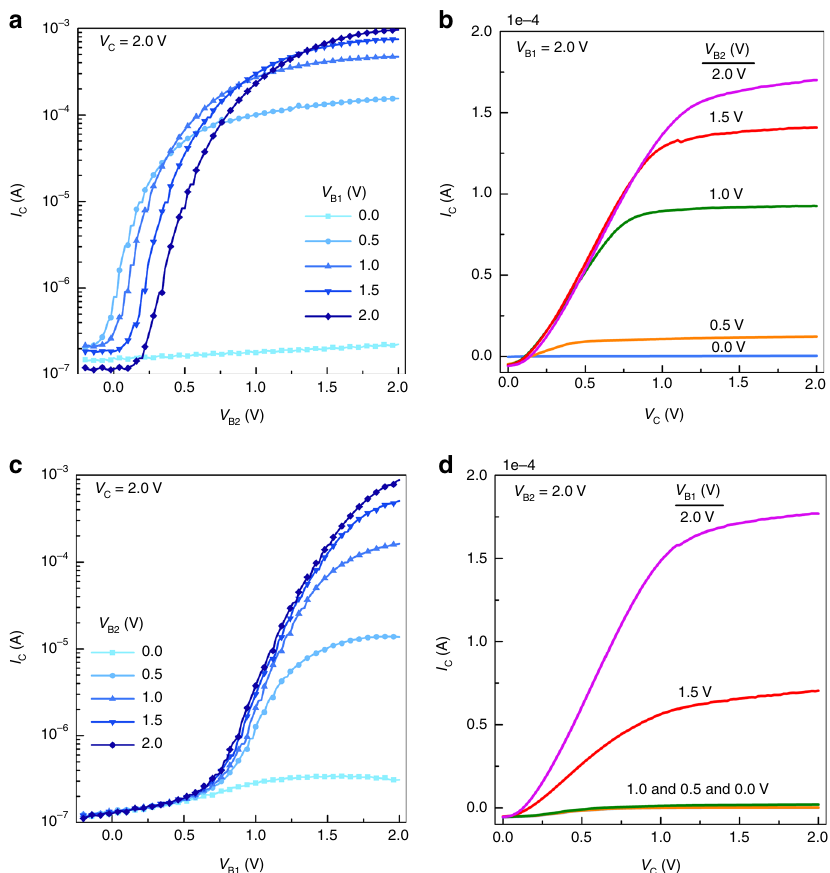
Fig. 3 Electrical characteristics of OPDBTs. a Transfer curves as a function of V B2 at different V B1 of 0, 0.5, 1.0, 1.5, and 2.0 V, respectively. b Output curves of OPDBTs measured under constant V B1 of 2.0 V and V B2 of 0, 0.5, 1.0, 1.5, and 2.0 V, respectively. c Transfer curves as a function of V B1 at different V B2 of 0, 0.5, 1.0, 1.5, and 2.0 V, respectively. d Output curves of OPDBTs measured under constant